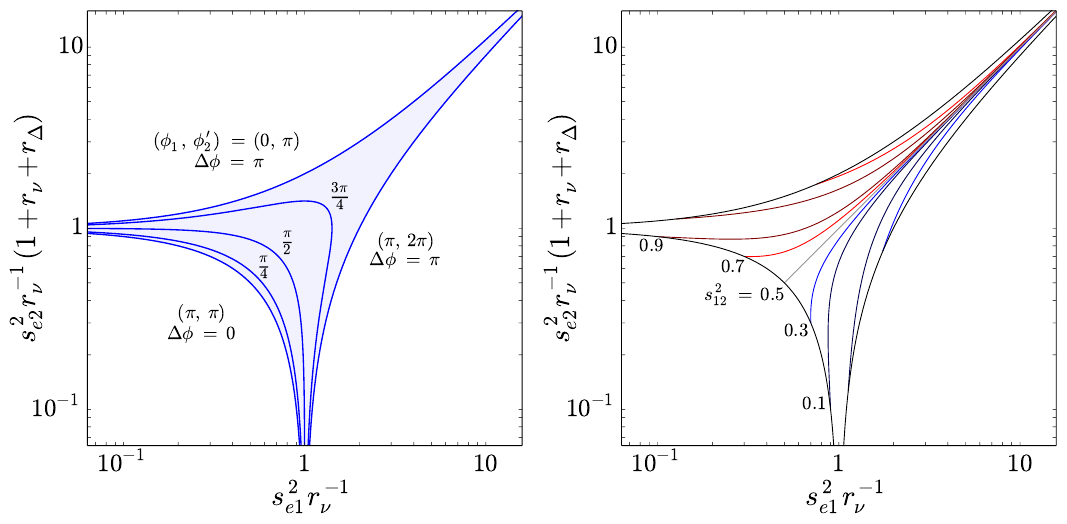
Figure 3 . Left: Heavy state CP phase di(cid:11)erence (cid:1) (cid:30) = (cid:30) 1 mixing strengths s 2 and s 2 . The axes are normalised by r (cid:23) = m (cid:23) =m N e 1 e 2 ( r (cid:1) = (cid:1) m N =m N ), respectively, so that allowed region applies for an arbitrary choice of the 1 neutrino mass eigenvalues. The edges of the allowed region are determined by the limiting values for ( (cid:30) 1 ; (cid:30) 0 ) as indicated. Right: Sterile-sterile neutrino mixing strength s 2 2 s 2 , setting (cid:14) = e 2